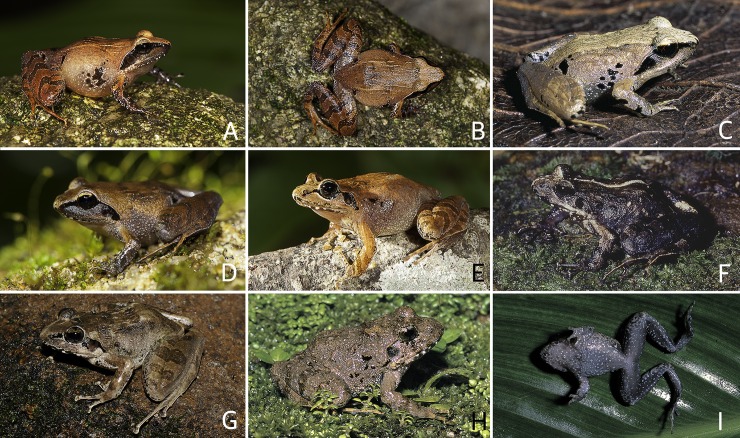
Genus Sallywalkerana in life.(A–D) S. diplosticta. (A, B) An adult male (SDBDU 2015.2956), from Pandipath. (A) Dorsolateral view. (B) Dorsal view. (C) An adult male (SDBDU 2003.40103), from Athirimala. (D) An adult male (SDBDU 2011.283), from Pandimotta. (E–G) S. leptodactyla. (E) An adult female (SDBDU 2013.911), from Mattupetti, dorsolateral view. (F) An adult female (SDBDU 2002.917), from Kodaikanal. (G) An adult female (SDBDU 2004.40336), from Valparai. (H, I) S. phrynoderma, an adult male (SDBDU 2002.1181), from Grass Hills. (H) Dorsolateral view. (I) Ventral view.